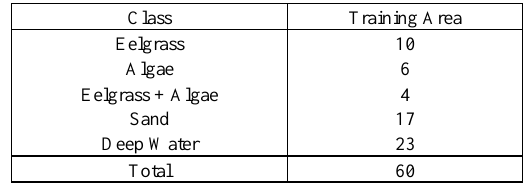
Number of training area per class for the Sentinel-2 image